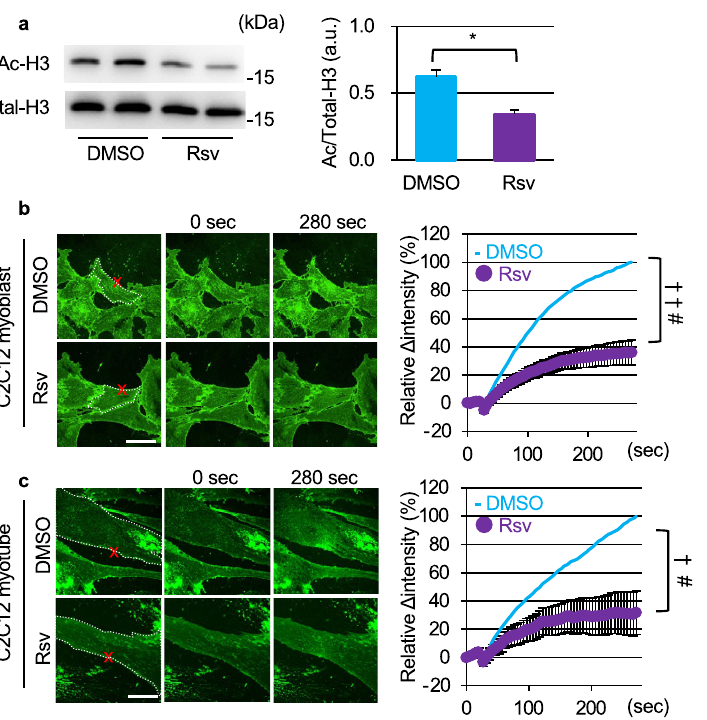
Figure 1. Resveratrol promotes membrane resealing in C2C12 myoblasts and myotubes. ( a ) Immunoblots of acetylated (Ac-; top) and total (bottom) histone H3 in C2C12 cells 12 h after treatment with a vehicle (DMSO) or 50 μM of resveratrol (Rsv; n = 3). ( b ) Plasma membrane repair kinetics upon laser injury measured by membrane-impermeable FM 1-43 dye influx (green). Representative images before and after the laser injury of DMSO- (top) and Rsv- (bottom) treated C2C12 cells. X-marks (red) indicate laser injury points. Dotted lines (white) indicate cellular shapes and it is the region of FM 1-43 dye influx measured. Right panel shows the time course of FM 1-43 dye influx after laser injury in C2C12 cells myoblasts treated with DMSO or Rsv (n = 11 and 20). ( c ) Representative images (left) and time course of FM 1-43 dye influx (right) before and after laser injury in C2C12 myotubes treated with DMSO (top) or Rsv (bottom) (n = 18). Scale bars of images are 60 μm ( b and c ). Data are represented as means ± SD ( a ) or SEM ( b and c ). A significant difference was determined by a two- tailed Student’s t -test: * P < 0.05. For ( b ) and ( c ), † indicates P < 0.05 at the last time point (280 s), and # indicates P < 0.05 based on the AUC value (area under the